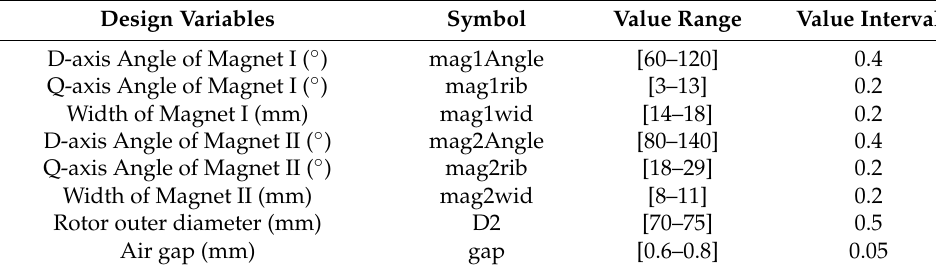
Table 5. Optimization factor value